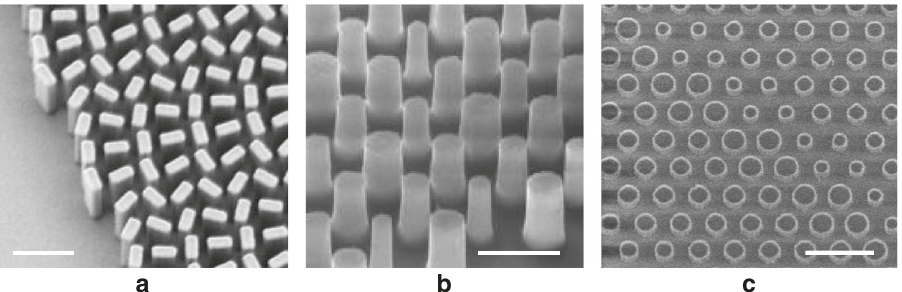
Fig. 2 Scanning electron microscope (SEM) images of several metalens antenna forms. a Nano- fi ns used for geometrical phase, reproduced with permission from ref. 9 , Copyright 2016 AAAS. ( b ) Nano-rods used as truncated waveguides, reproduced with permission from ref. 7 , Springer Nature and c Nano-disks used for Huygens metalens, reproduced with permission from ref. 12 , De Gruyter. Scale bar is 1 µ